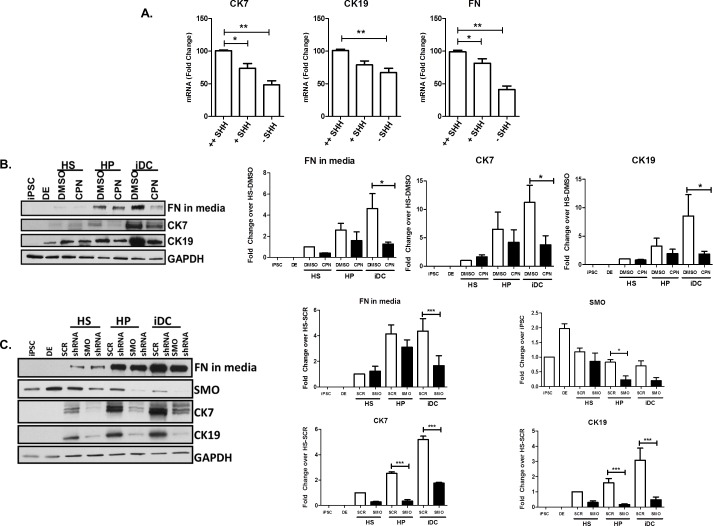
Shh critically mediates cholangiocyte differentiation.A. Reduced Shh dosing reduces mRNA levels of CK7, CK19, and FN (++Shh = 100 ng/ml Shh administered for 8 days, +Shh = 100 ng/ml Shh administered for 4 days, -Shh = no Shh administration). B. Inhibition of Shh signaling using CPN at HS, HP and iDC phases impairs cholangiocyte maturation and FN deposition as assessed by protein levels of CK7, CK19, and released FN. Bar graphs on the right depict the densitometry results showing quantitative reductions in FN, CK7 and CK19. C. SMO shRNA at the HS, HP and iDC phases of differentiation reduces acquisition of CK7 and CK19, and release of FN in media. Bar graphs on the right depict the densitometry results showing quantitative reductions in SMO, FN, CK7 and CK19. The data are shown as means ± standard error. *p < 0.05, ** p <0.01, ***p<0.001.